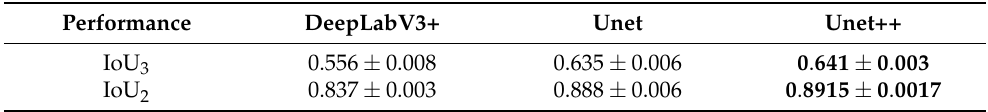
Figure 3. Performanceon test data belonging to different groups based on models trained on different training data. The first row contains the mean values of IoU 2 . The second row contains standard errors of mean IoU 2 . Each column corresponds to one of the selected network architectures—DeepLavV3+, Unet, Unet++. Table 2. Performance depending on the model architecture. The training and testing were carried out on 68% and 32% of the whole dataset,